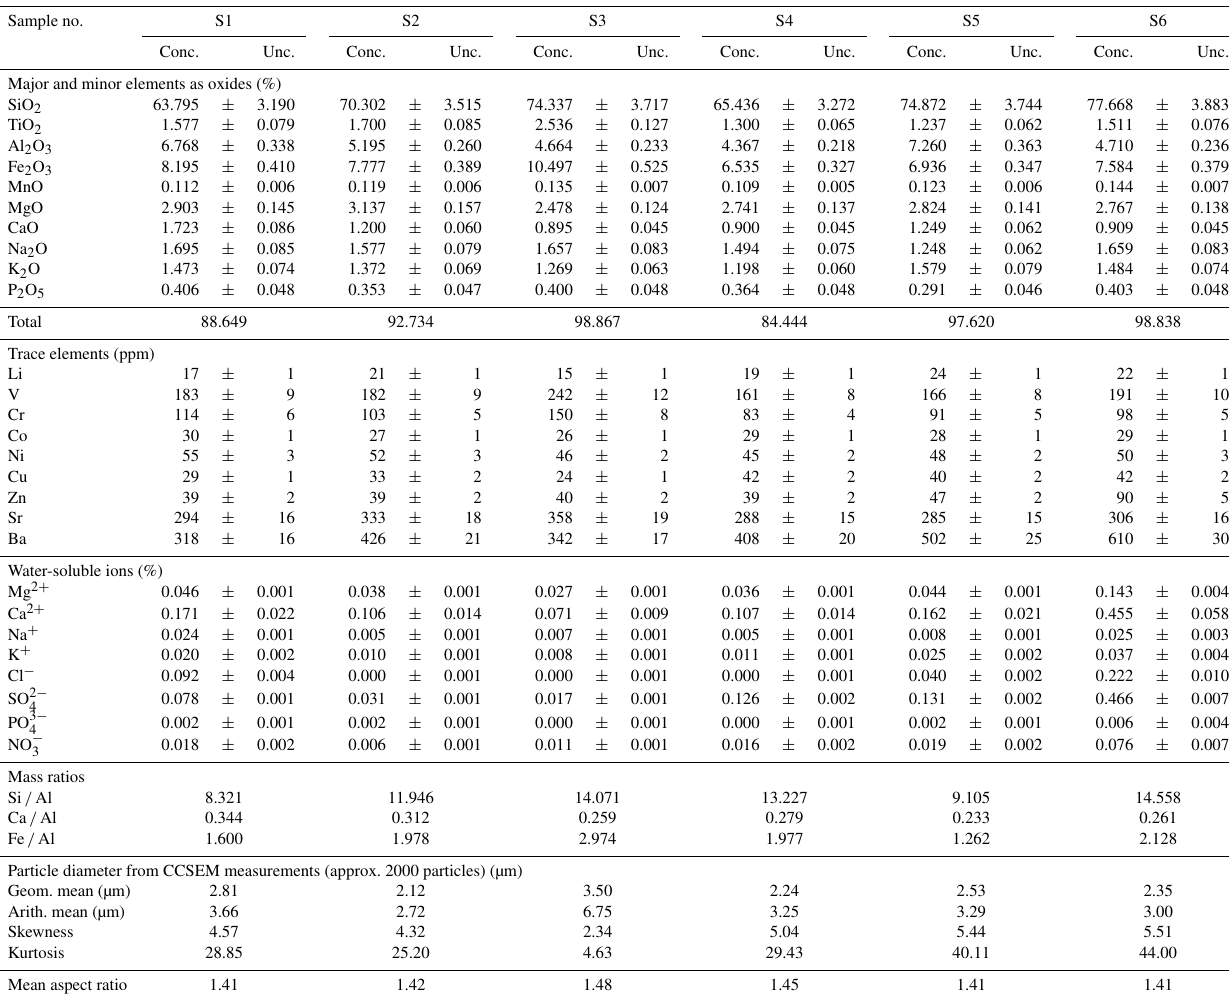
Table A1. Major, minor and trace element concentrations (Conc.) and analytical uncertainties (Unc.) of grab samples S1 to S3 collected near Al Nasaif and S4 to S6 collected near Ar R¯ayis, all along the Red Sea coastal region. Also tabulated are elemental mass ratios, statistics of the individual particle sizes and morphology as measured by